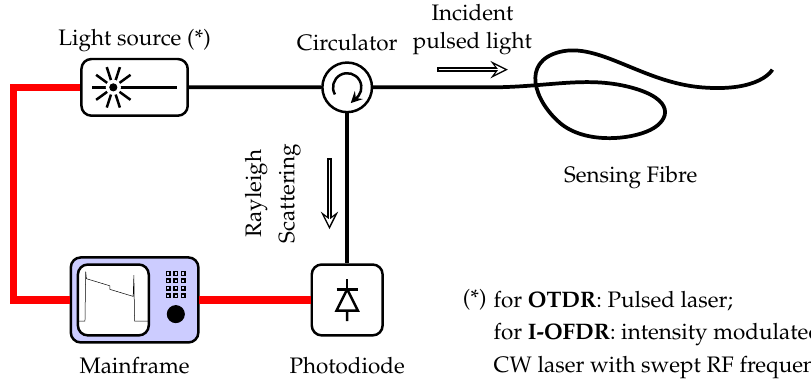
Figure 1. The principle of operation of the OTDR and I-OFDR schemes (CW: continuous wave; OTDR: optical time domain reflectometer; I-OFDR: incoherent optical frequency domain reflectometer; RF: radio frequency). Modified from